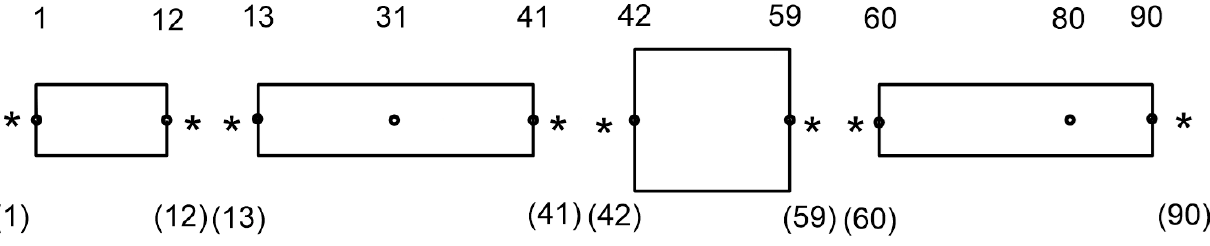
Figure 3. Computational diagram of shafting system